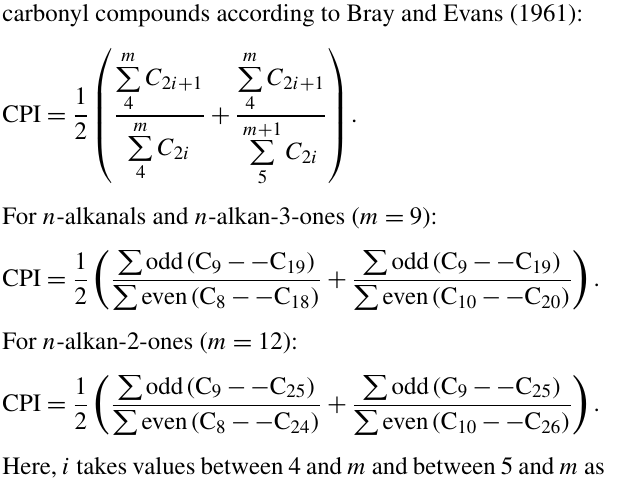
Table 1. The carbon preference index (CPI) and C max for n -alkanals, n -alkan-2-ones, and n -alkan-3-ones in this study and published data. Location, Sampling n -alkanals n -alkan-2-ones n -alkan-3-ones sampling